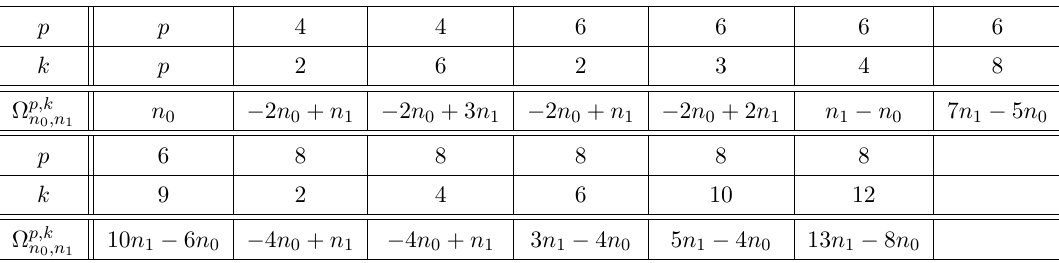
coefficients for various values of p and k . These were computed by using Table 6 . Values of Ω p,k n 0 ,n 1 values in table 4 and mapping ( b 1 , b 2 ) to ( n ) (table 5). Notice in the first column we give a 0 , n 1 general expression for Y p,p